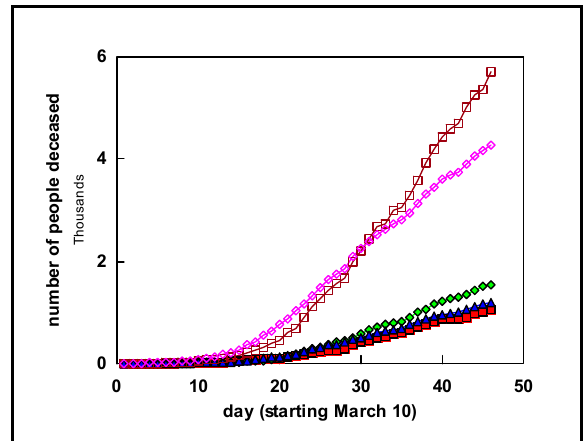
Figure 4. Number of deaths (ordinate) during the period 10 March–24 April 2020 in three German ‘Bundesländer’ (federal states)—North-Rhine Westphalia (red squares), Bavaria (green diamonds), and Baden-W ű rttemberg (blue triangles)—with Germany (brown open squares) and the Netherlands (pink diamonds).